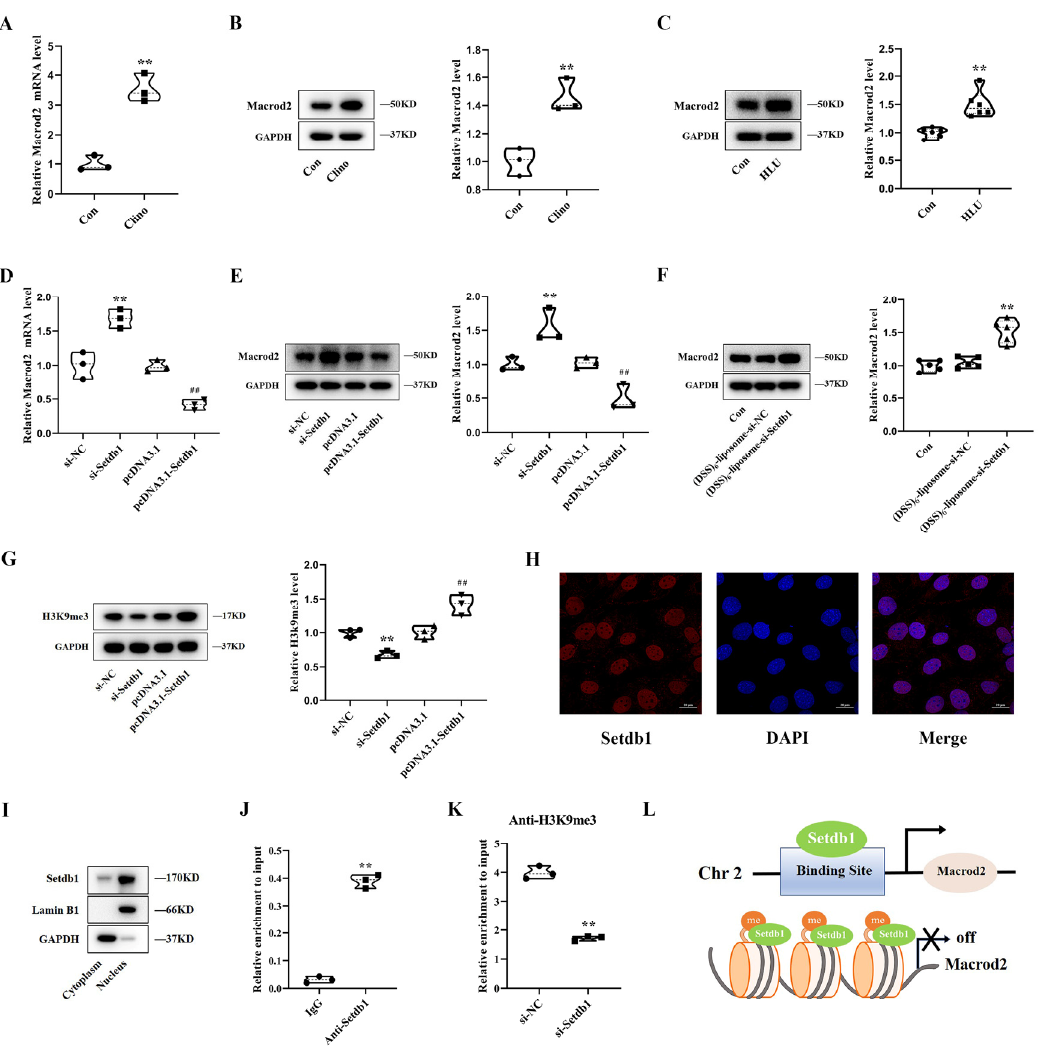
Figure 3. Setdb1 silences Macrod2 expression by catalyzing the formation of H3K9me3 in the pro- moter region. ( A ) The mRNA level of Macrod2 in MC3T3-E1 cells after exposure to clinorotation for 48 h by qRT-PCR ( n = 3). Student’s two-sided t -test. ( B ) Western blotting analyses of Macrod2 protein level in MC3T3-E1 cells ( n = 3). Student’s two-sided t -test. ( C ) Protein levels of Macrod2 in hindlimb bone tissues by Western blotting in the indicated groups ( n = 6). Student’s two-sided t -test. ( D ) qRT-PCR analysis of Macrod2 mRNA levels in MC3T3-E1 cells transfected with si-Setdb1, pcDNA3.1-Setdb1, or the corresponding controls ( n = 3). One-way ANOVA followed by LSD’s mul- tiple comparisons test. ** p < 0.01 vs. the cells transfected with si-NC. ## p < 0.01 vs. the cells trans- fected with pcDNA3.1. ( E ) Western blotting analyses of Macrod2 protein level in MC3T3-E1 cells after transfection of si-Setdb1, pcDNA3.1-Setdb1, or the corresponding controls. One-way ANOVA followed by LSD’s multiple comparisons test. ** p < 0.01 vs. the cells transfected with si-NC. ## p < 0.01 vs. the cells transfected with pcDNA3.1. ( F ) Protein levels of Macrod2 in bone tissues by West- ern blotting in the indicated groups ( n = 5). One-way ANOVA followed by LSD’s multiple compar- isons test. ** p < 0.01 vs. the mice injected with (DSS) 6 -liposome-si-NC. ( G ) Protein levels of H3K9me3 by Western blotting from each group ( n = 3). One-way ANOVA followed by LSD’s mul- tiple comparisons test. ** p < 0.01 vs. the cells transfected with si-NC. ## p < 0.01 vs. the cells trans- fected with pcDNA3.1. ( H ) The localization of Setdb1 was examined by immunofluorescence stain- ing under normal conditions ( n = 3). Scale bar, 20 μ m. ( I ) The protein level of Setdb1 in cytoplasm and nucleus by Western blotting ( n = 3). ( J ) ChIP-PCR assay illustrating Setdb1 association with the